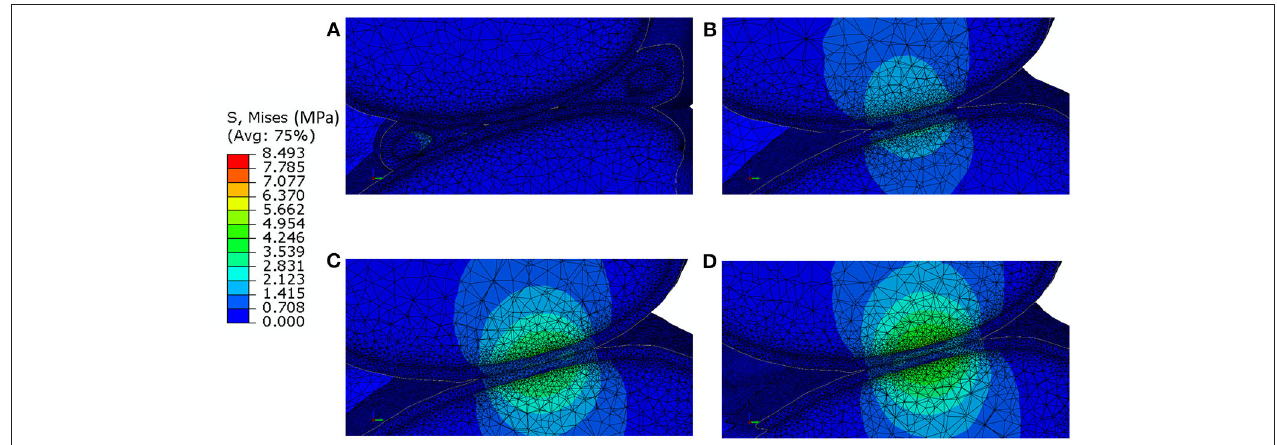
FIGURE 4 | Von-Mises stress distribution at 0.3N reaction force in a sagittal section passing through the lateral condyle and containing the point of contact between the femoral cartilage and the tibia cartilage for: (A) model including individual cartilage layers with meniscus; (B) model including individual cartilage layers without meniscus; (C) model including homogeneous cartilage layers with different thickness values for the lateral and medial condyles; (D) model including homogeneous cartilage layer with the same value of thickness for both condyles. It should be noted that the stress distribution in the bone does not take into account for the microstructural properties of the bone in that